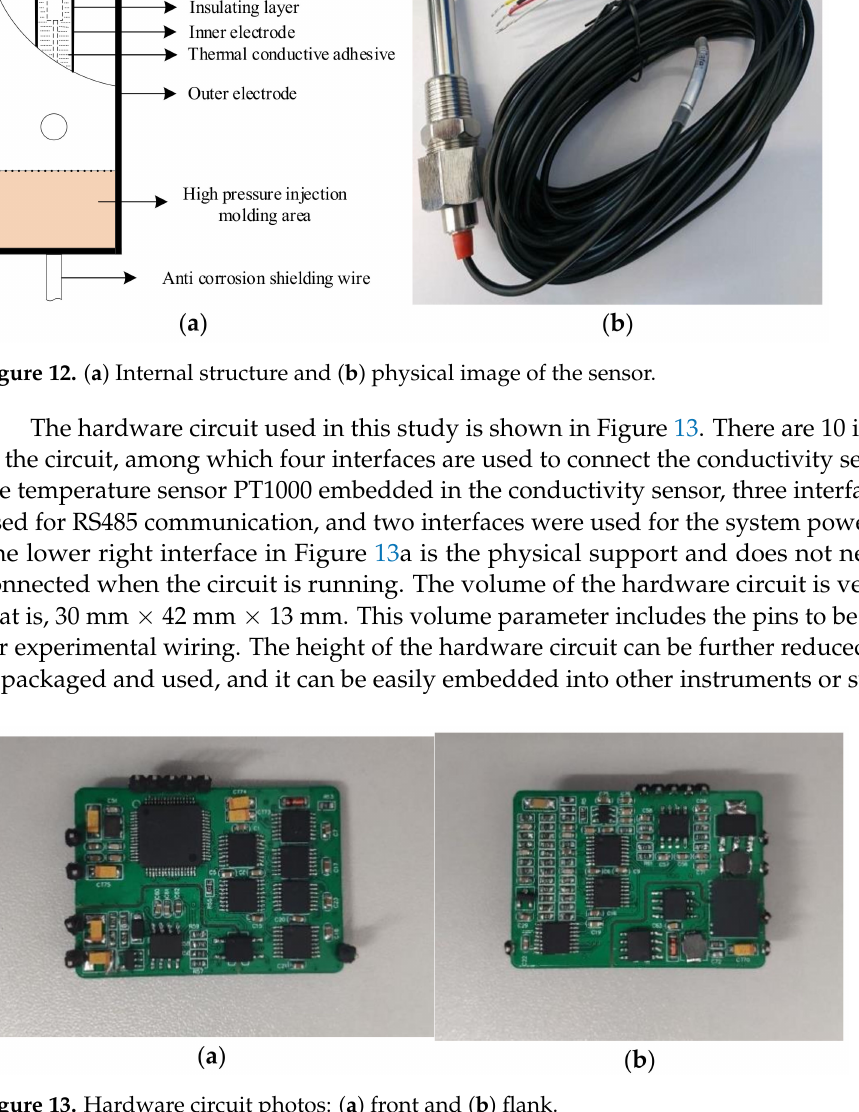
Figure 13. Hardware circuit photos: ( a ) front and ( b )